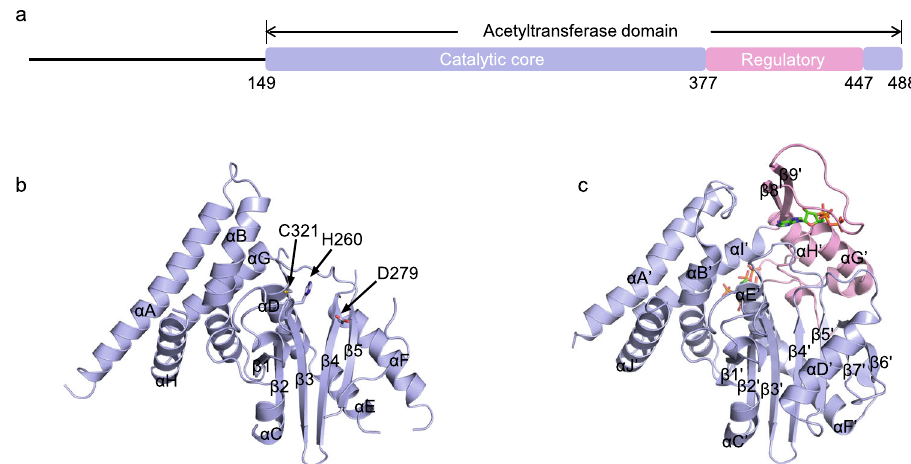
Fig. 1 Structures of PopP2 in apo and InsP6-bound state. a Schematic illustration of PopP2 protein, with the regulatory domain in pink and the catalytic core in blue. Similar colors are used in other panels unless otherwise indicated. b Crystal structure of PopP2 in apo state. The α -helices and β -strands are counted in alphabetic and numeric orders, respectively. The catalytic triad (H260/D279/C321) is shown as a stick representation. The regulatory domain (residues 377 – 447) is absent. c Crystal structure of PopP2 in complex with InsP6 and CoA (PDB code: 5W3Y). InsP6 and CoA are shown in stick